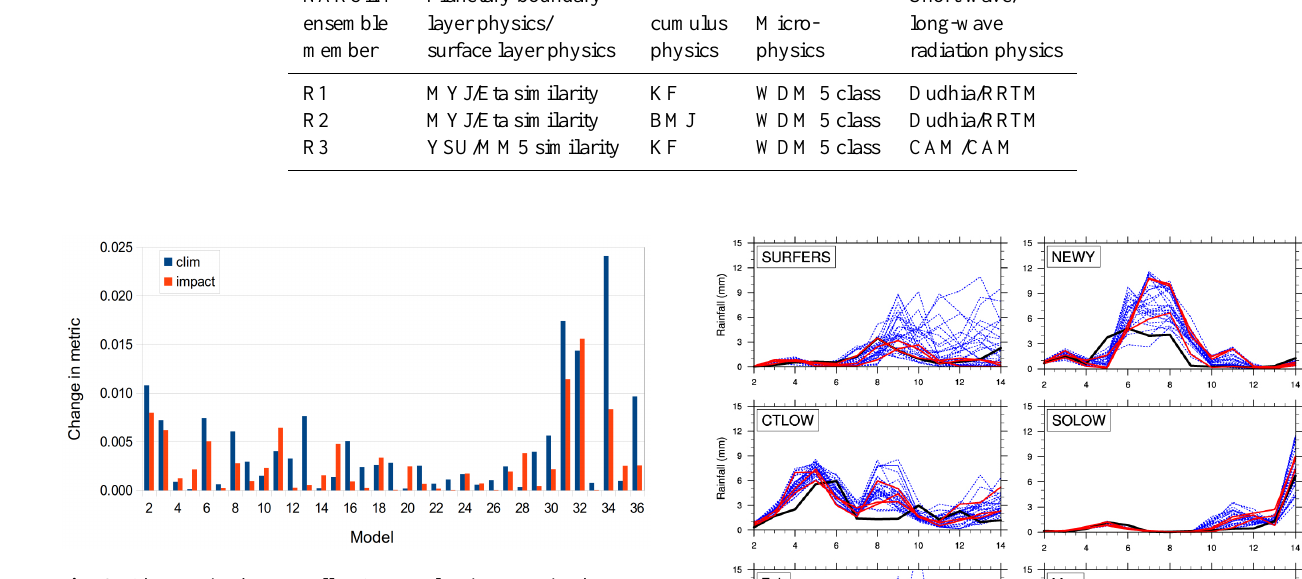
Fig. 2. Change in the overall RCM evaluation metrics between neighbouring models ordered from the best model (left) to the worst model (right).